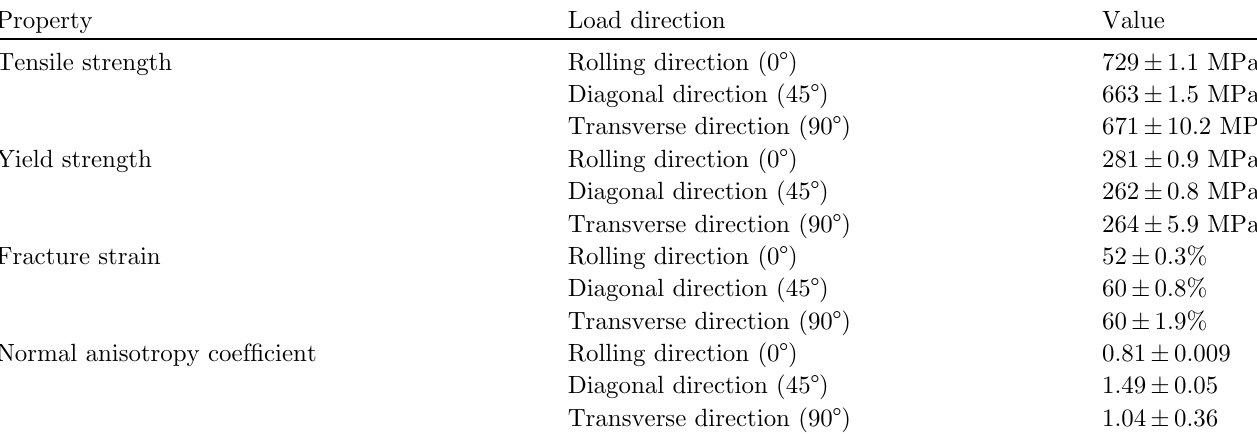
Table 1. Mechanical properties of the sheet. Property